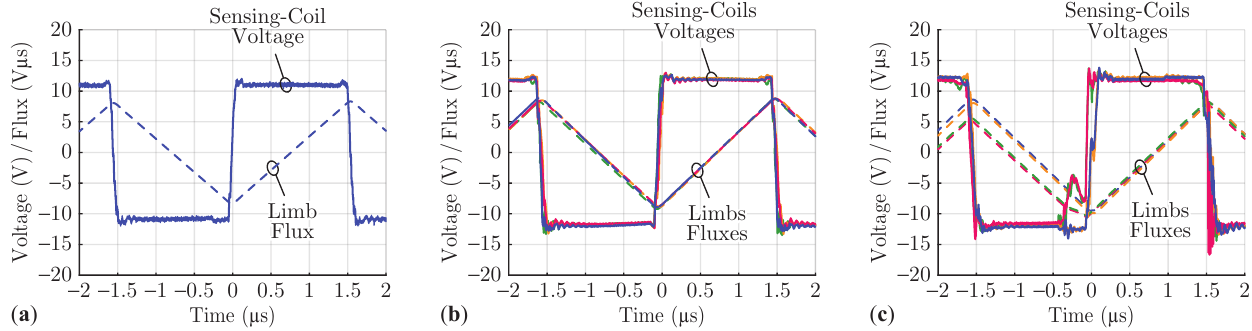
Figure 24. Measured induced voltages and limb fluxes (measured by sensing coils wound around the core limbs) for ( a ) the proposed snake-core transformer , and for the conventional matrix transformer with ( b ) balanced and ( c ) unbalanced reluctances, through the addition of an larger air gap in one leg. Output power is 40% load for all test